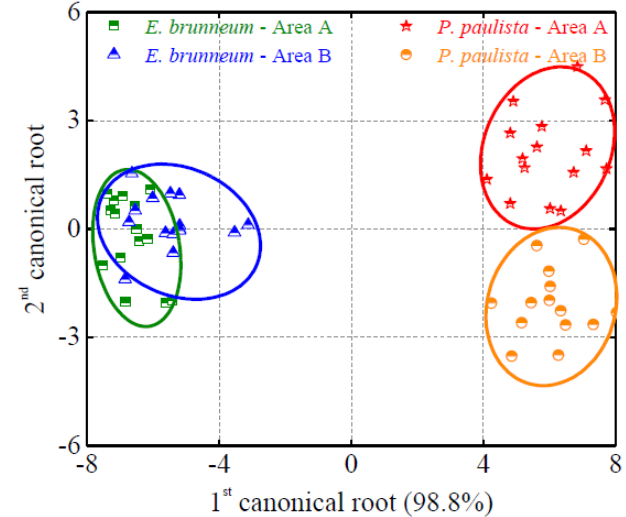
Fig 2 . Average infrared absorption spectra of venom glands and reservoirs from Polybia paulista wasps and Ectatomma brunneum ants. The highlighted regions represent the most important differences observed for intra- and interspecific interpretation, which were more precisely confirmed by data from figure